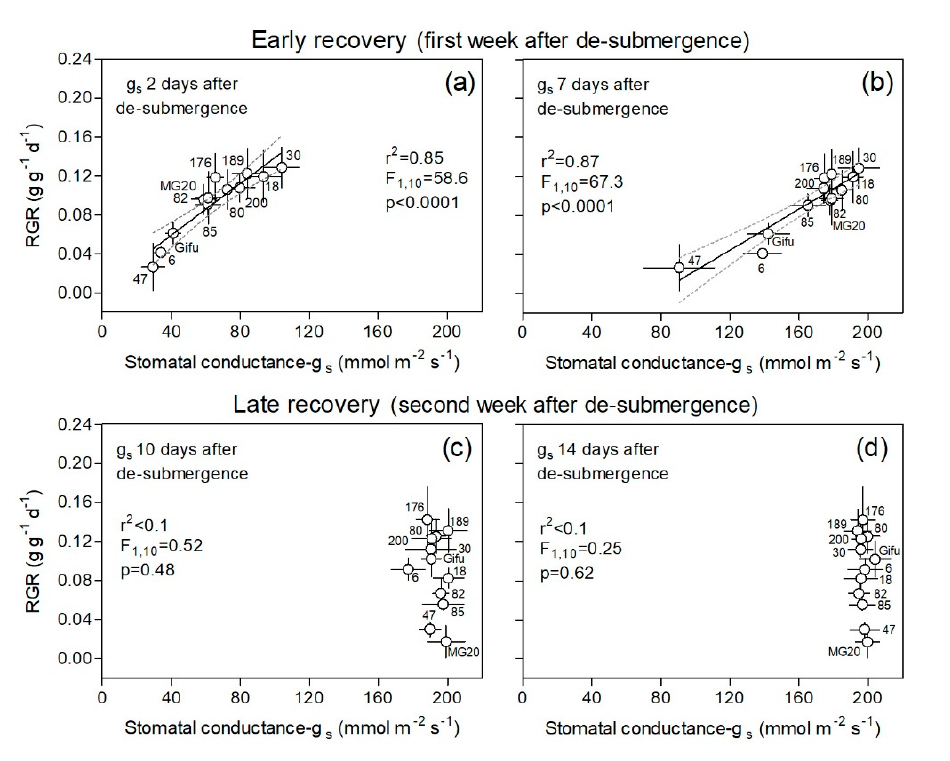
Figure 5. Plant relative growth rate (RGR) during ‘early’ and ‘late’ recovery vs. stomatal conductance (g s , mmol m − 2 s − 1 ) on the top-most fully expanded leaves at days 2, 7, 10, and 14 after de-submergence for plants of 12 genotypes of Lotus japonicus (10 recombinant inbred lines and their parents Gifu and MG20). The first week after de-submergence was used to explore the relationship between these variables in an ‘early recovery’ phase ( a , b ) and the second week in a ‘late recovery’ phase ( c , d ). Values are means ± standard errors (n = 6–8 for RGR and n = 5 for g s ). The stomatal conductance values corresponding to the control treatment ranged between 187.2 and 208.8 mmol m − 2 s − 1 (all data for each genotype and measurement dates are available in Table S3).